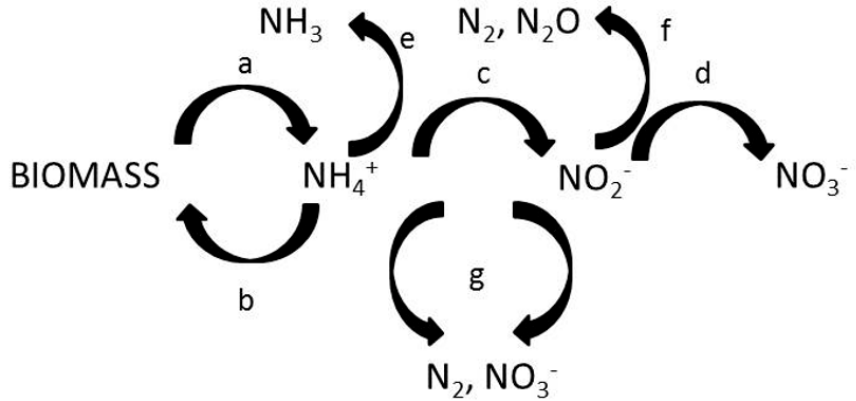
Figure 3. Transformation of nitrogen compounds in a biofilm: a—ammonification,